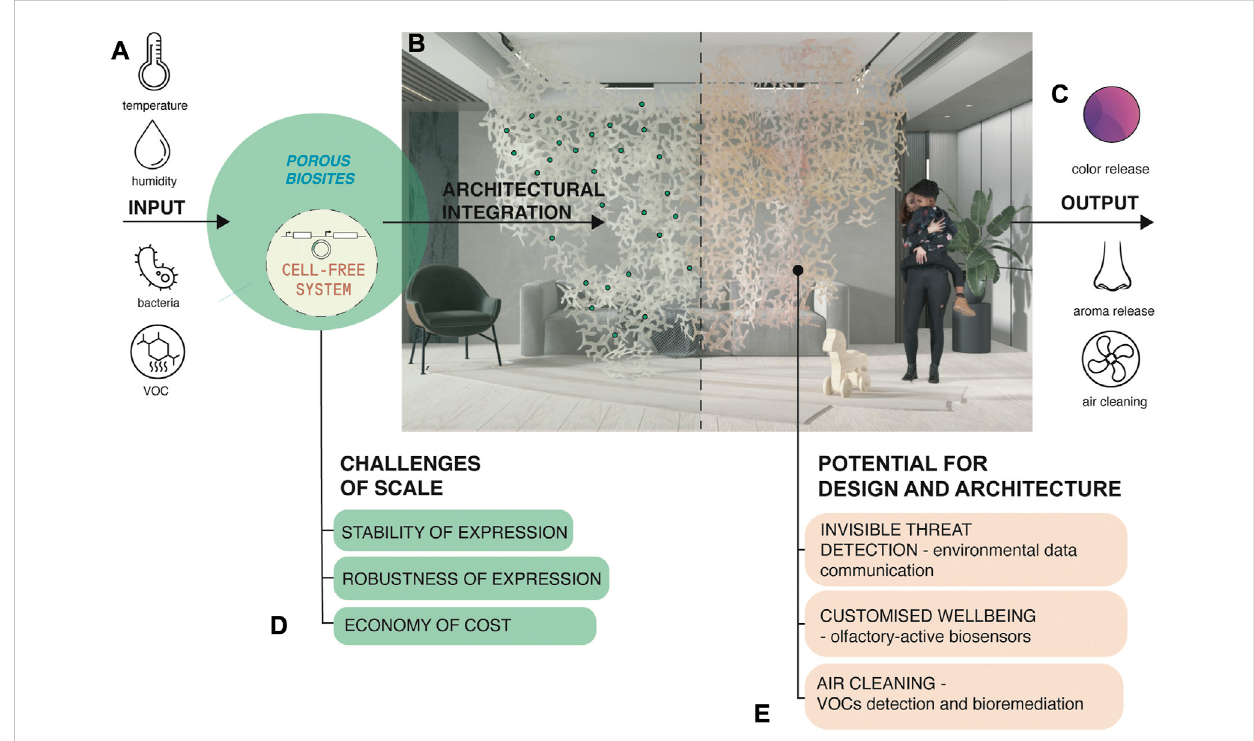
FIGURE 5 Scaling up cell-free systems for architectural solutions with embedded environmental responsiveness: a roadmap of potential and challenges. (A) Inputs into the envisioned system. (B) Biosites as porous bioactive zones within larger structures. Structures can be composed of multiple modules. (C) Outputs of the envisioned system. (D) Challenges to scaling up the technology for architectural and product applications. (E) Envisioned applications in design and